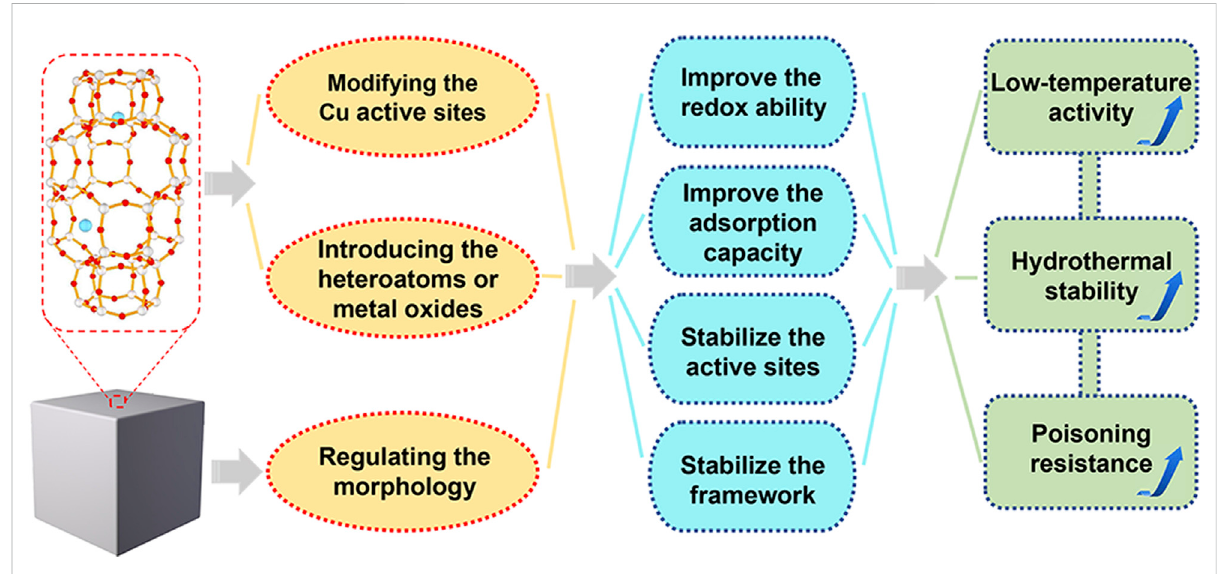
FIGURE 1 The optimization strategies and corresponding principles of Cu-SSZ-13 catalysts for NH 3 -SCR reaction.